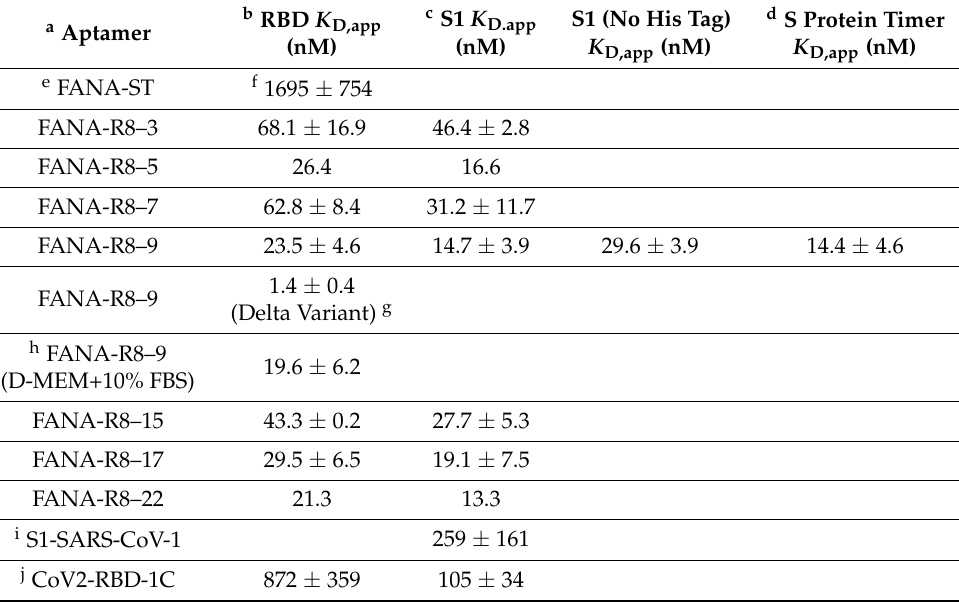
Table 1. Apparent equilibrium dissociation constants ( K D ,app) for tested FANA